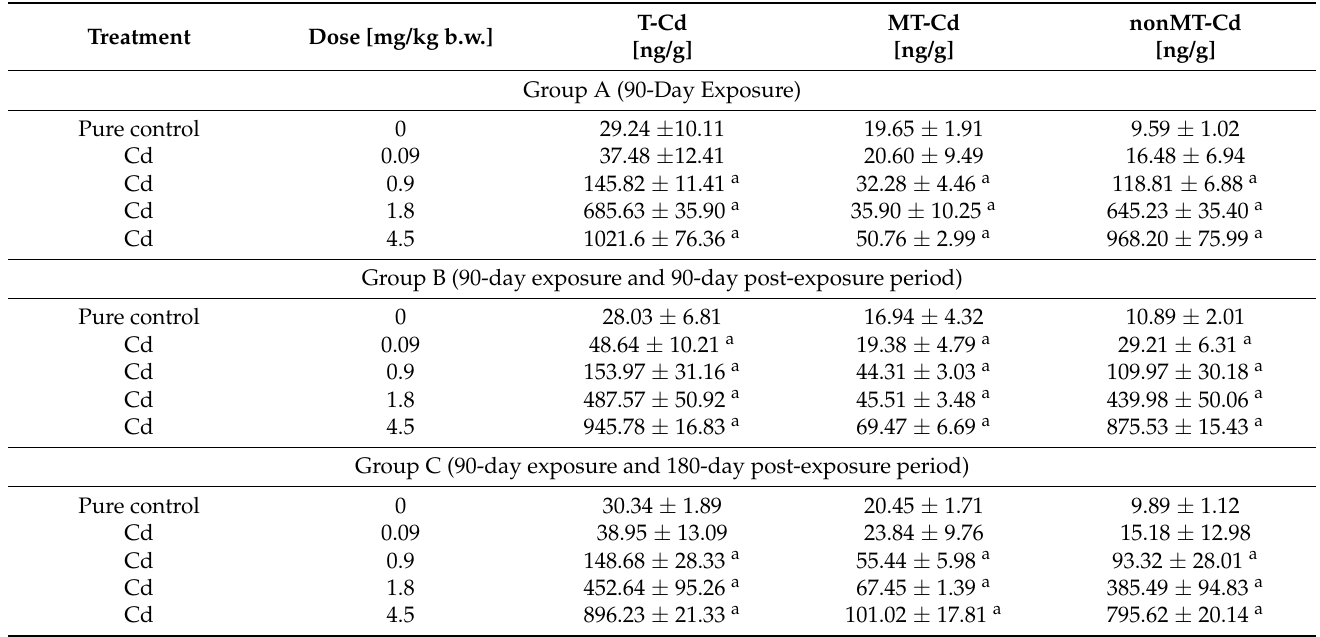
Table 1. Cd bound to MT (MT-Cd) and Cd not bound to MT (nonMT-Cd) in the total Cd pool (T-Cd) in the uterus following 90-day oral exposure to Cd, and 90 and 180 days post-exposure. Treatment Dose [mg/kg